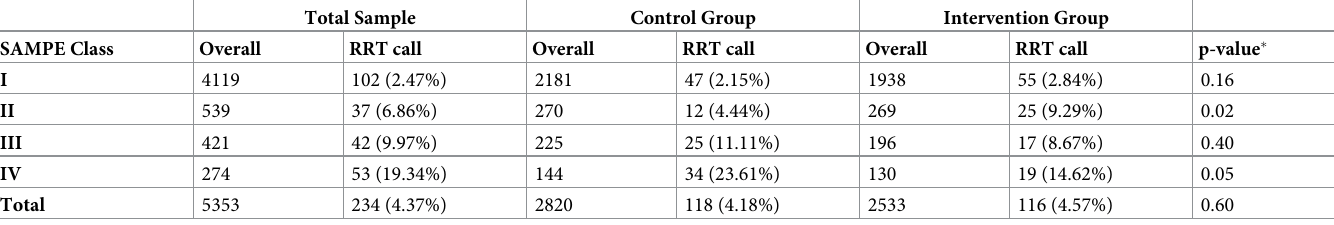
Table 2. Rapid Response Team calls at 30 postoperative days before and after the quality improvement